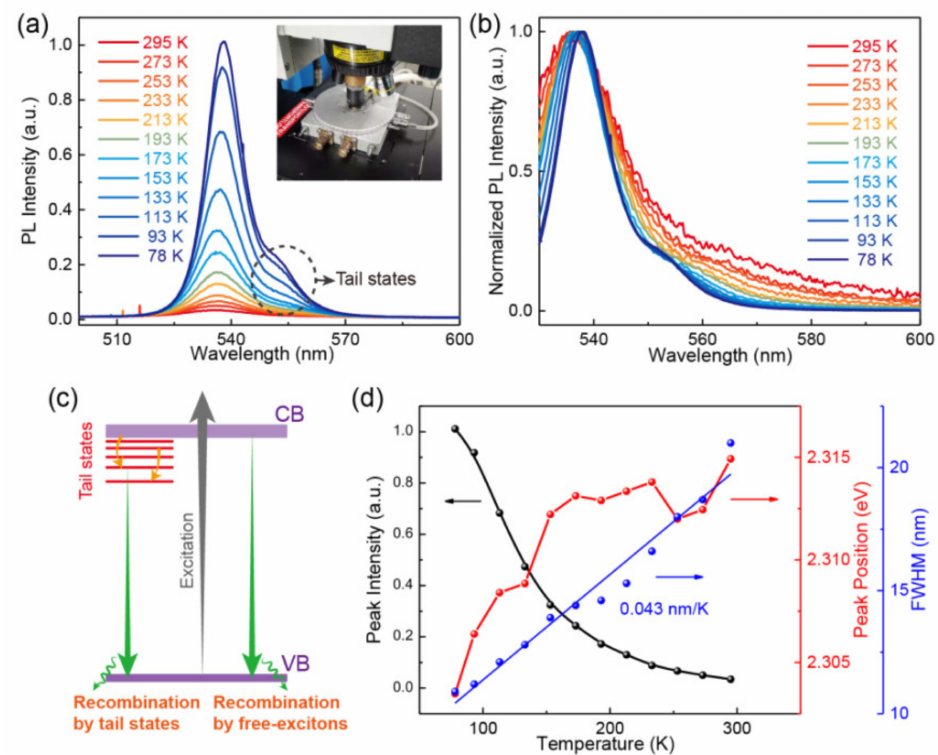
Figure 2. ( a ) PL spectra under different temperatures, where the inset denotes the head of the cooling equipment. ( b ) Nor- malized PL spectra under different temperatures. ( c ) Schematic diagram of energy band configuration showing the recombination photoluminescence mechanism. ( d ) The abstracted PL peak intensity, peak positions, and full width at half maximum (FWHM) as a function of